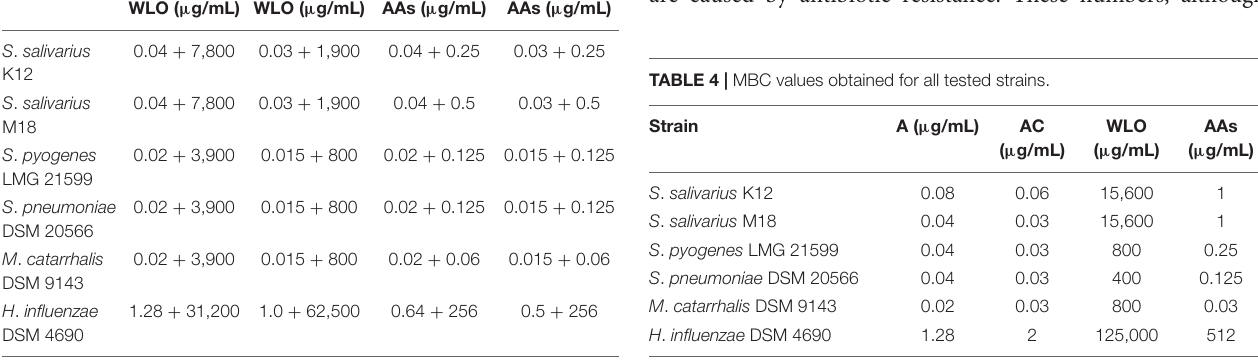
TABLE 3 | MIC values obtained for the combination of antibiotics with winterized lentisk oil and antibiotics with anacardic acids. Strain